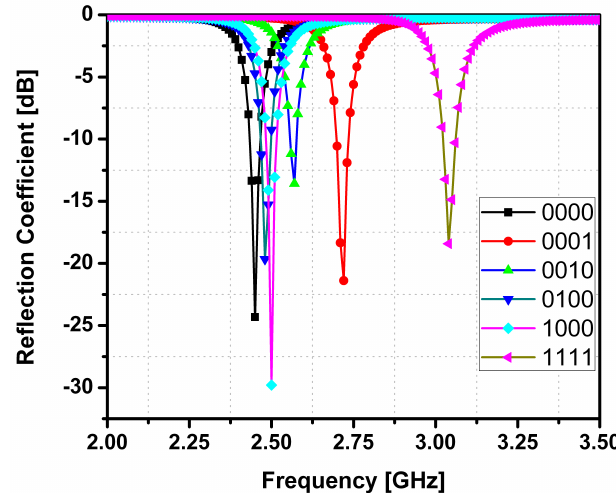
Figure 3. Simulated reflection coefficients of the proposed SIW